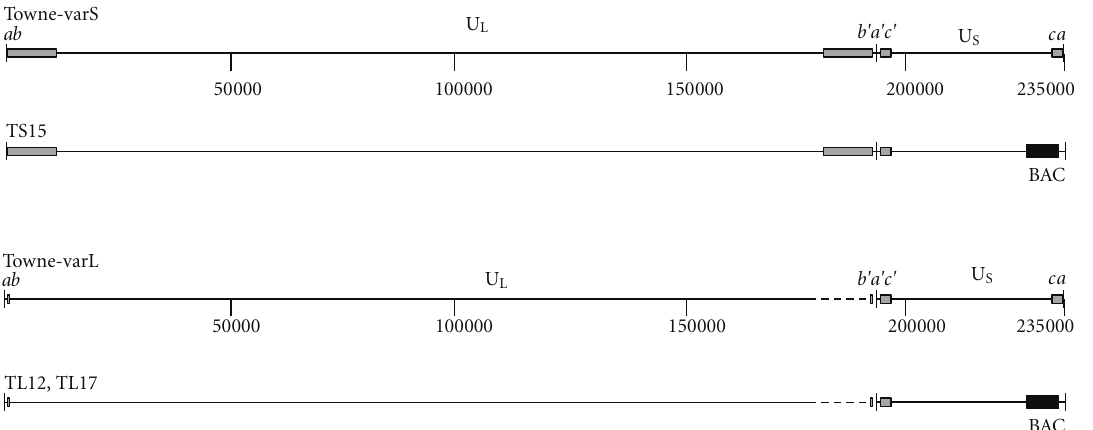
Figure 1: Genome maps of Towne-varS, Towne-varL, and BAC-cloned viruses. Inverted repeats b/b (cid:2) and c/c (cid:2) (grey boxes) flank unique long (U L ) and unique short (U S ) regions to delineate long and short genome segments. One or more copies of the a sequence (black bars) can be found at long segment termini and inverted at the long and short segment junction ( b (cid:2) a (cid:2) c (cid:2) ), while one or no copies are found at short segment termini [9, 10] (for simplicity single copies are shown). Dashed lines indicate U L sequences in varL that are missing from varS; black boxes represent the BAC ori cassette (BAC). Nucleotide positions are indicated; genome features are approximately to